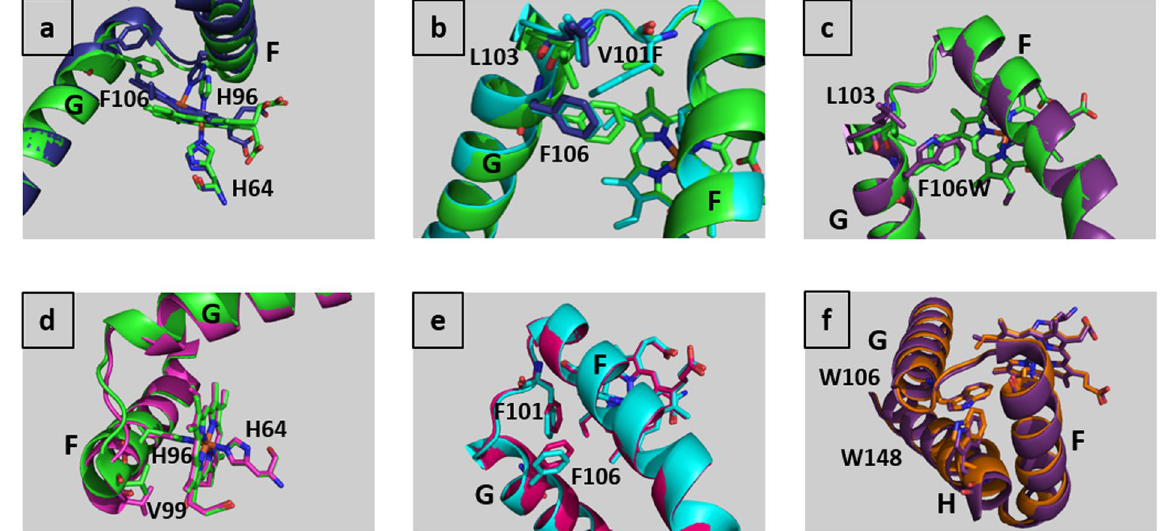
Figure 2. Structures of neuroglobin mutants compared to the wild-type one and high-pressure (HP) structures compared to ambient pressure (AP) structures. For clarity, only helix F, FG loop and helix G are shown in cartoon representation, and the heme, the distal and proximal histidines and notable residues in stick representation. (a) Carbonmonoxy Ngb structure (1w92, in dark blue) compared to WT AP (in green). (b) V101F AP (in cyan) and WT AP (in green). Leu 103 and Phe 106 from the carbonmonoxy structure (1w92, 100 K) are shown in dark blue for comparison. (c) F106W AP (in purple) and WT AP (in green). (d) WT HP- 310 (in magenta) and WT AP (in green). (e) V101F HP-240 (in red) and V101F AP (in cyan). (f) F106W HP- 310 (in orange) and F106W AP (in purple), helix H is shown in cartoon